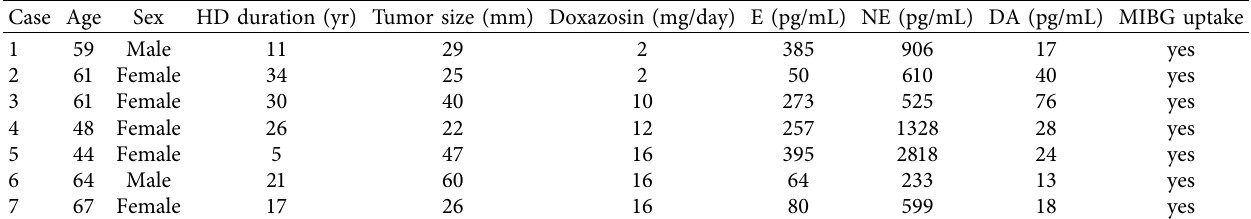
Table 1: Characteristics of the hemodialysis patient with pheochromocytoma.